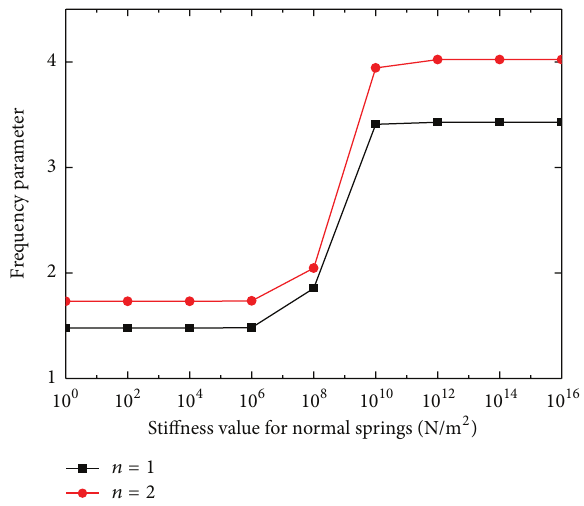
Figure 5: The effects of tangential boundary spring stiffness on frequency